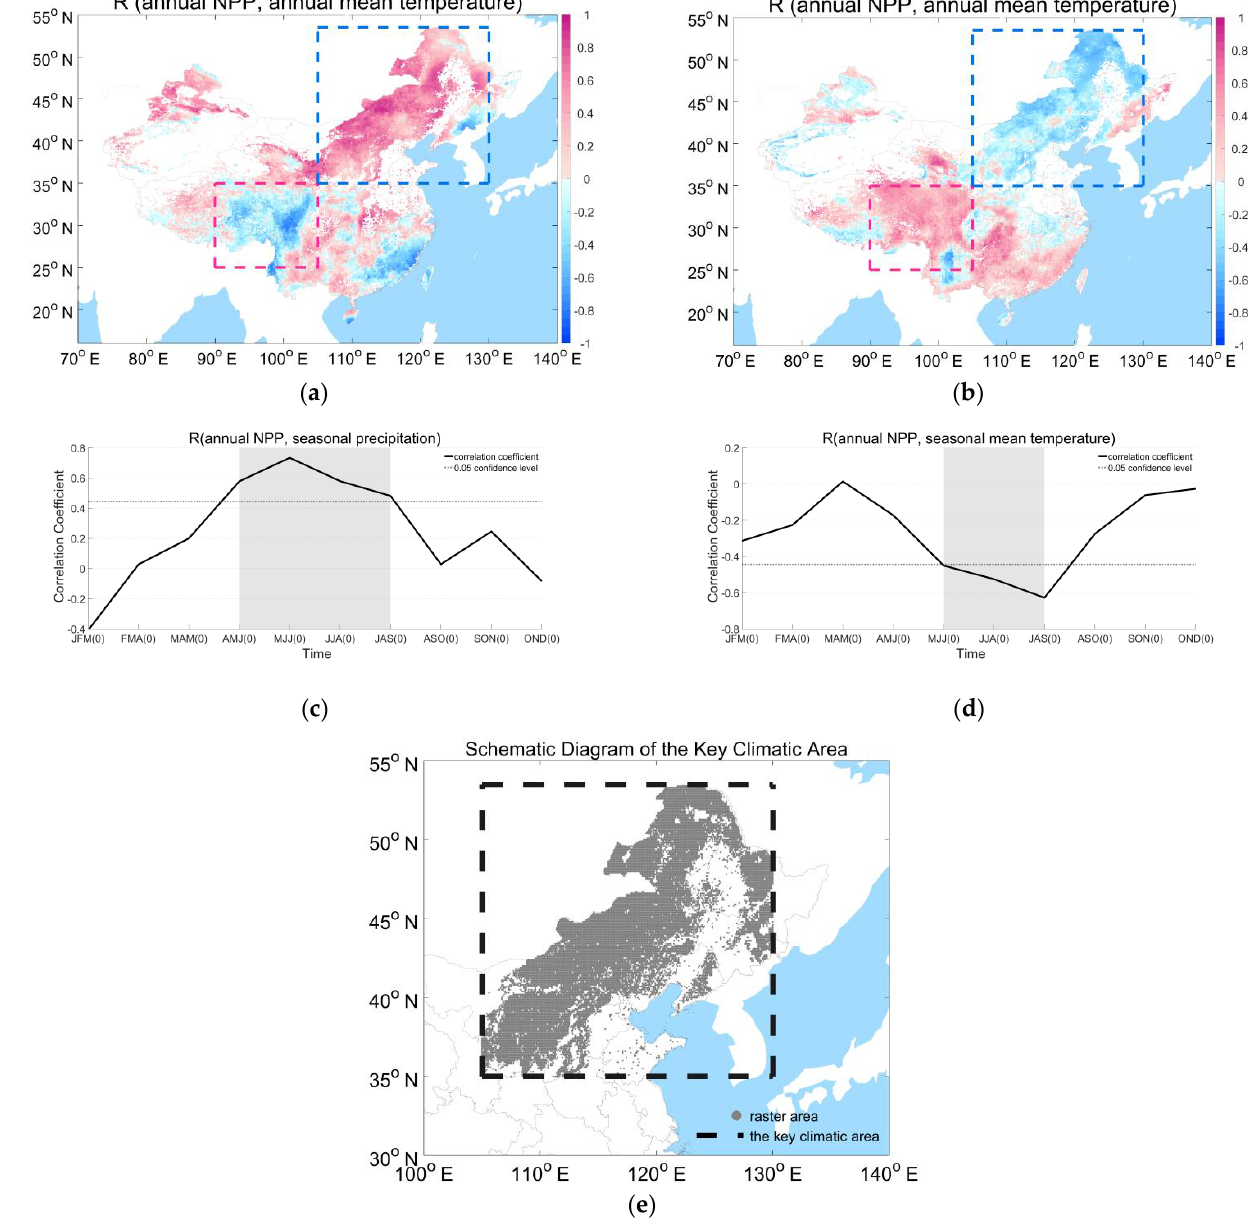
Figure 3. Spatial distribution of correlation coefficients between annual NPP and annual precipitation ( a ) and annual mean temperature ( b ), as well as correlation coefficients between annual NPP and seasonal precipitation ( c ) and correlation coefficients between annual NPP and seasonal mean temperature ( d ) in the key climatic area (solid line: correlation coefficients; dotted line: α = 0.05 reliability test; shaded: pass 0.05 reliability test). A schematic diagram of the climatic area, the intersection of raster points of the key climatic area is also presented, with the positive correlation coefficient between annual NPP and summer precipitation and the negative correlation coefficient between annual NPP and summer mean temperature; dotted box: key climatic area ( e ).